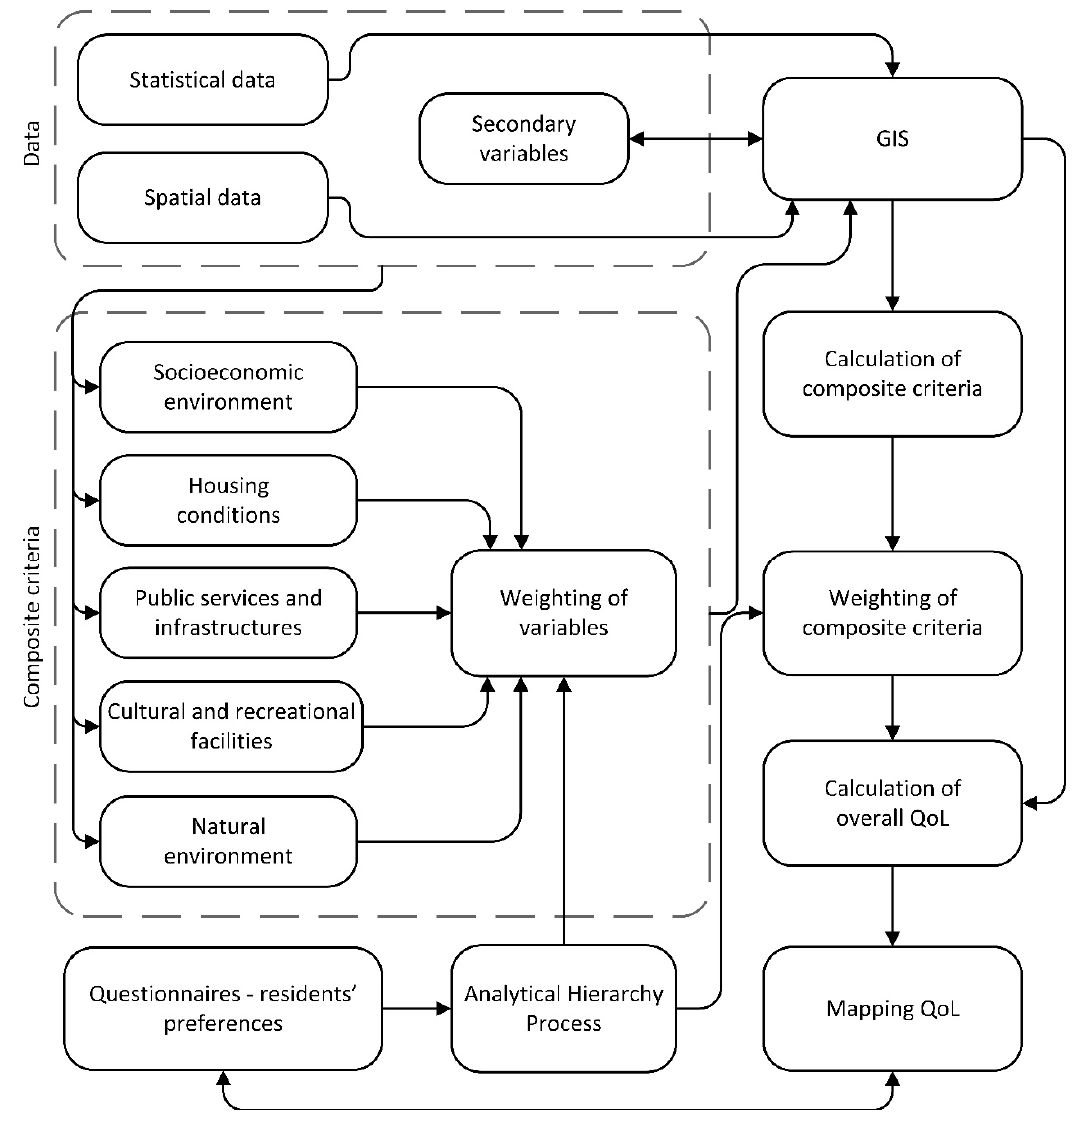
Figure 2. Flowchart of the proposed methodology.